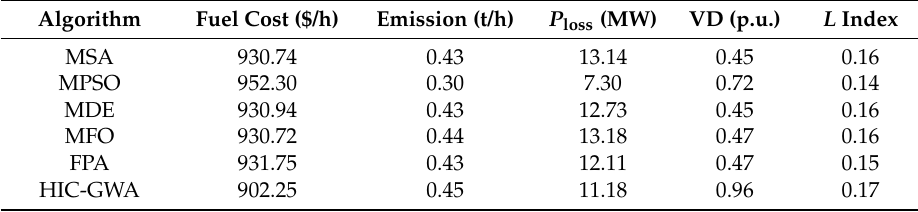
Table 7. Comparison of HIC-GWA with the literature for case study 3.